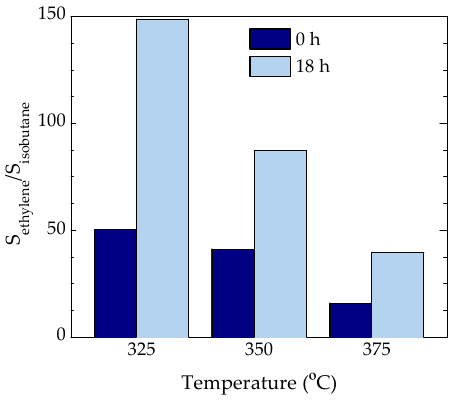
Figure 5. Effect of reaction temperature and time on stream (0 and 18 h) on the ethylene/isobutane selectivity ratio (referred to C units).